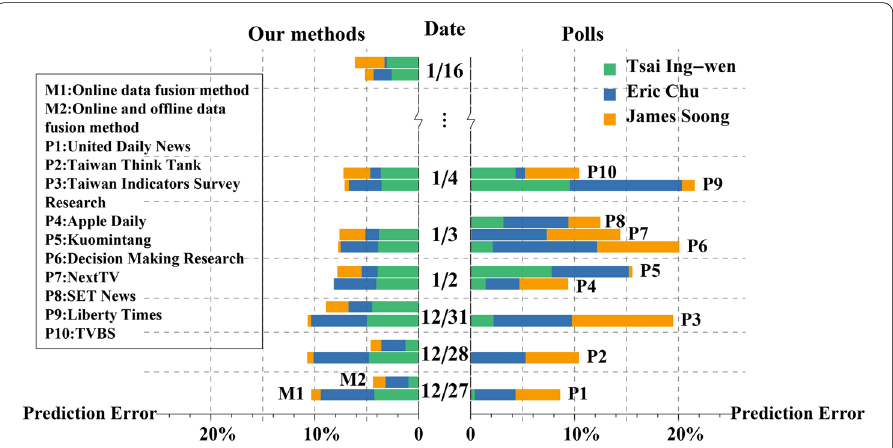
Figure 2 Timeline of the absolute prediction errors of final polls and data fusion methods. The bars on the left side of the timeline represent the prediction errors of the data fusion methods. In each interval between two gray dashed lines, there are two bars. The lower bar represents the absolute error of the online data fusion method, and the upper bar represents the absolute error of the online–offline data fusion method. The interval between two gray horizontal dashed lines indicates one day. The bars on the right side of the timeline show the prediction errors of the final polls from ten pollsters. Comparison of the bars on both sides shows that the absolute prediction errors of the signal fusion methods are smaller than those of the